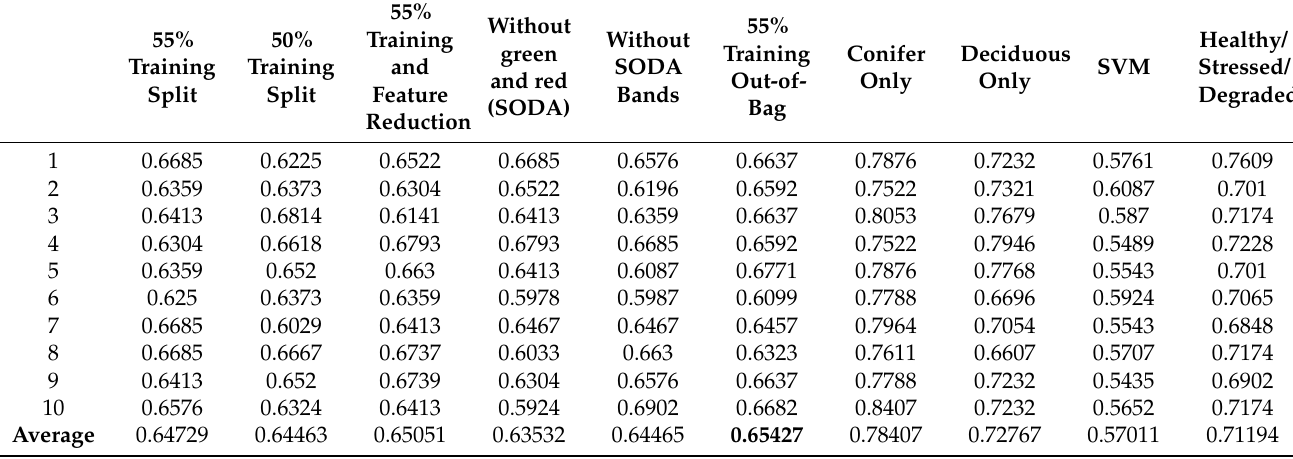
Table 4. UAS imagery classification accuracies for each random forest and SVM classification method. The highest accuracy for our five-class scheme is shown in